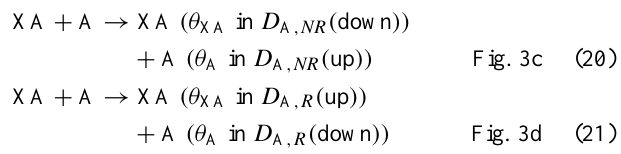
F T (θ) = F NR (θ) + F R (θ) and G(θ) = 1 / 2 { F T (θ) + F T (π − θ) } .